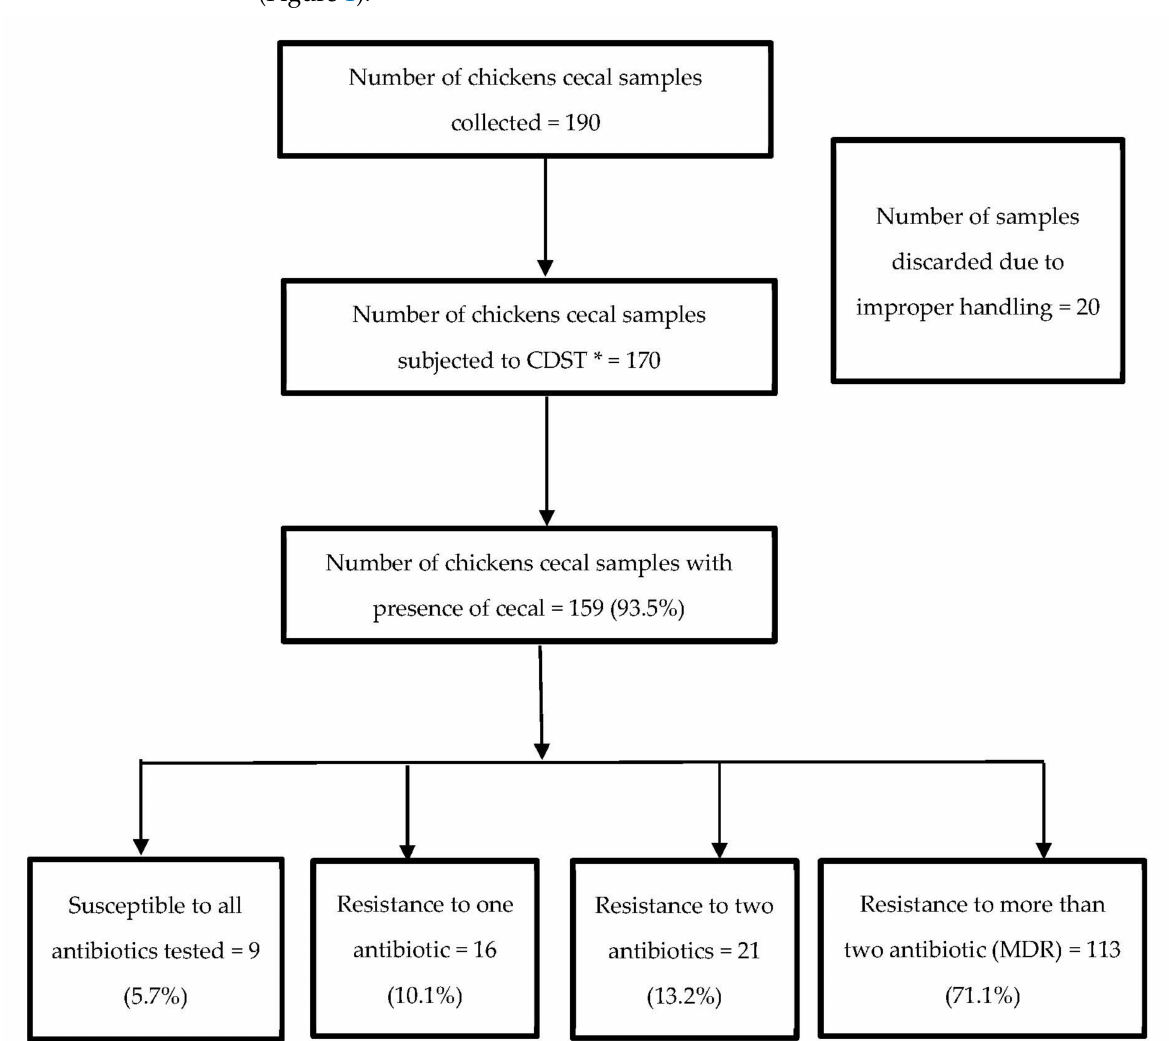
Figure 1. Flowchart depicting the pattern of E. coli in chicken cecal samples and resistance to antimicrobials in the Dhulikhel municipality of Nepal from September to December 2021. * Culture and drug sensitivity